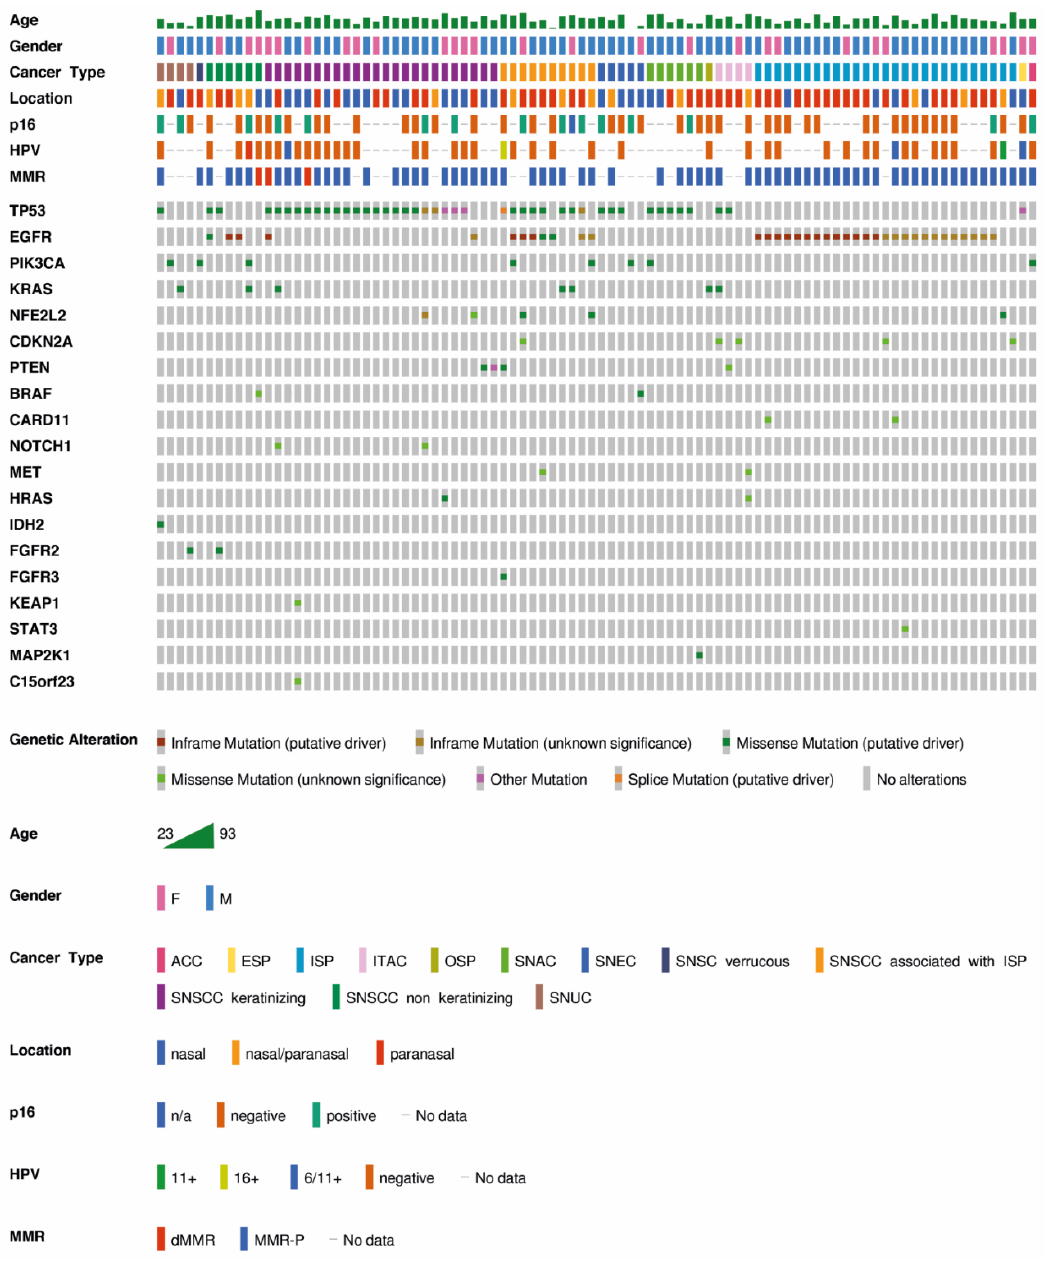
Figure 4. Next generation sequencing (NGS) results of a sinonasal carcinoma collective. A total of 136 FFPE samples from sinonasal tumors, from 90 male and 46 female individuals, were analyzed by next generation-targeted sequencing. Age at diagnosis ranged from 23 to 93 years (mean age 61 years, SD 13 years) (cases that were WT in all tested gene regions were not shown). EGFR mutations were significantly associated with ISP and SP-associated carcinomas, whereas TP53 mutations could be detected in many different tumor types. In contrast to PIK3CA mutations, KRAS and EGFR mutations were mutually exclusive. HPV positive cases predominantly carried a WT sequence in the EGFR gene.